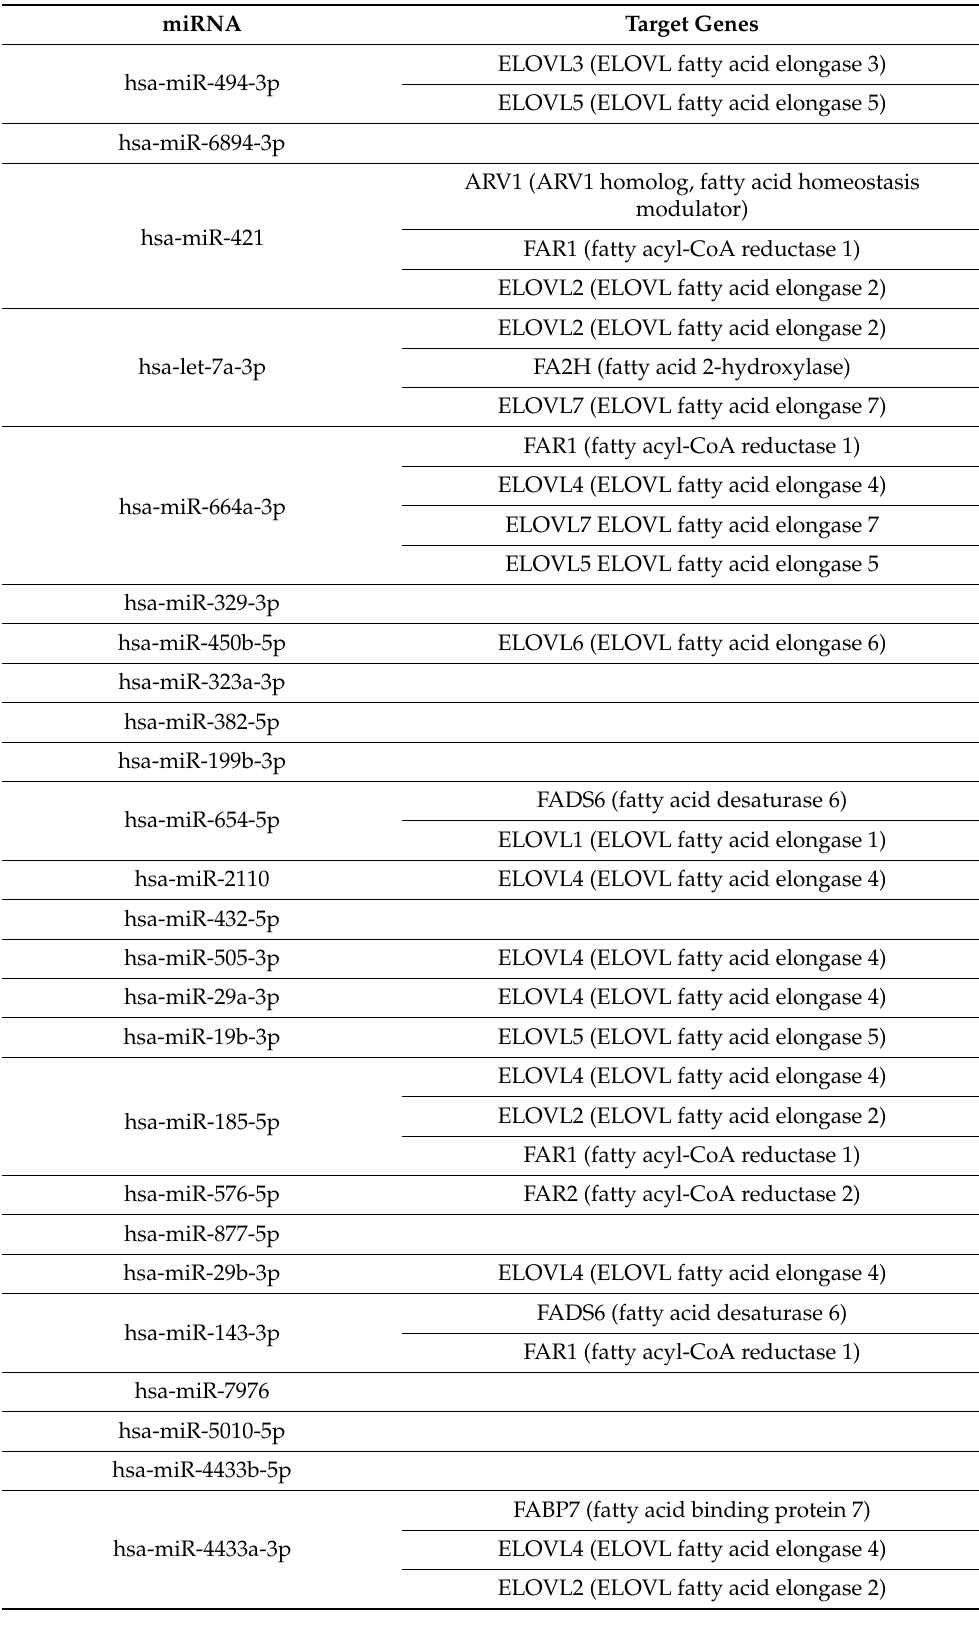
Table 3. Predicted target genes related to fatty acids for the selected miRNAs